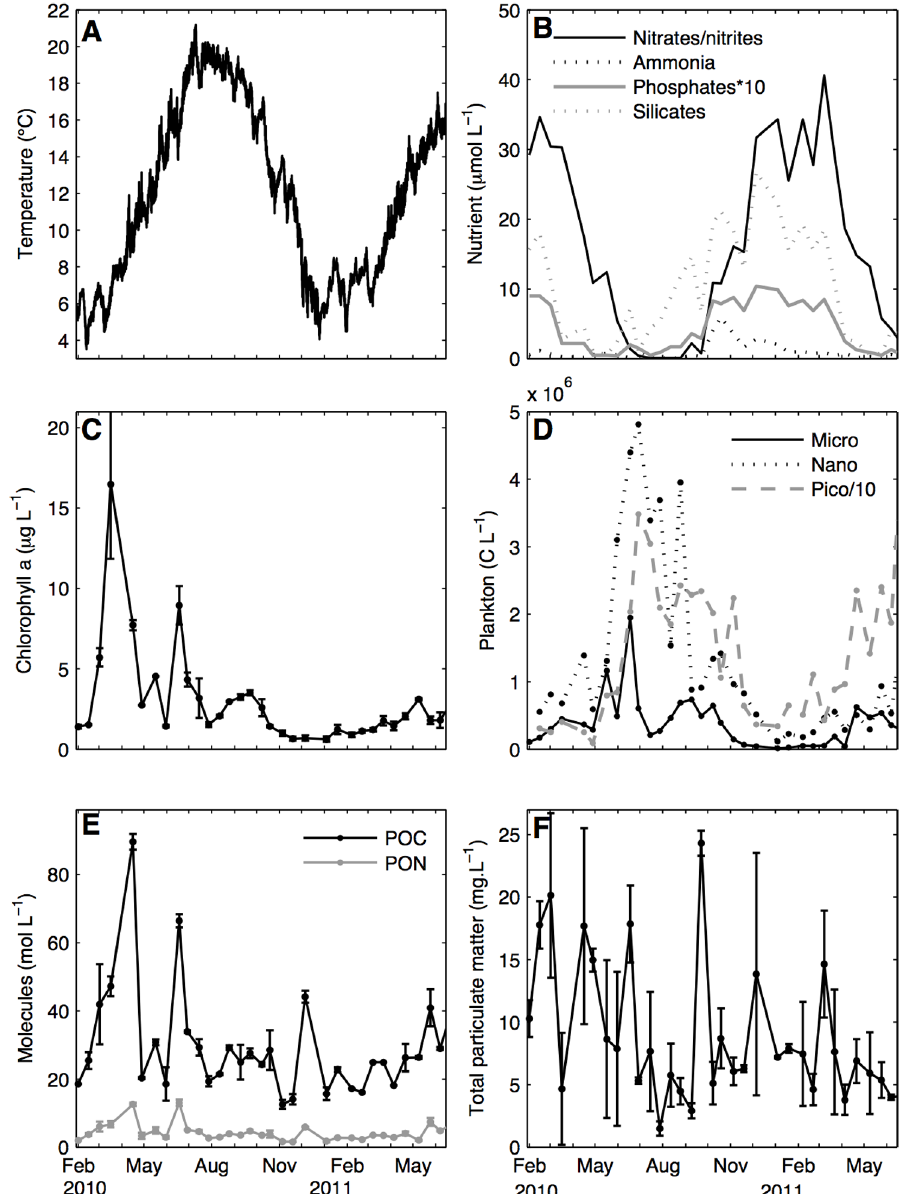
Figure 3. Observed environmental descriptors during the experiment. Average daily sea water temperature (A), nutrients (B), chlorophyll a (C), abundance of different sizes of plankton (D), particular organic carbon and nitrogen (E) and total particulate matter (F) were measured in 2010 and 2011.